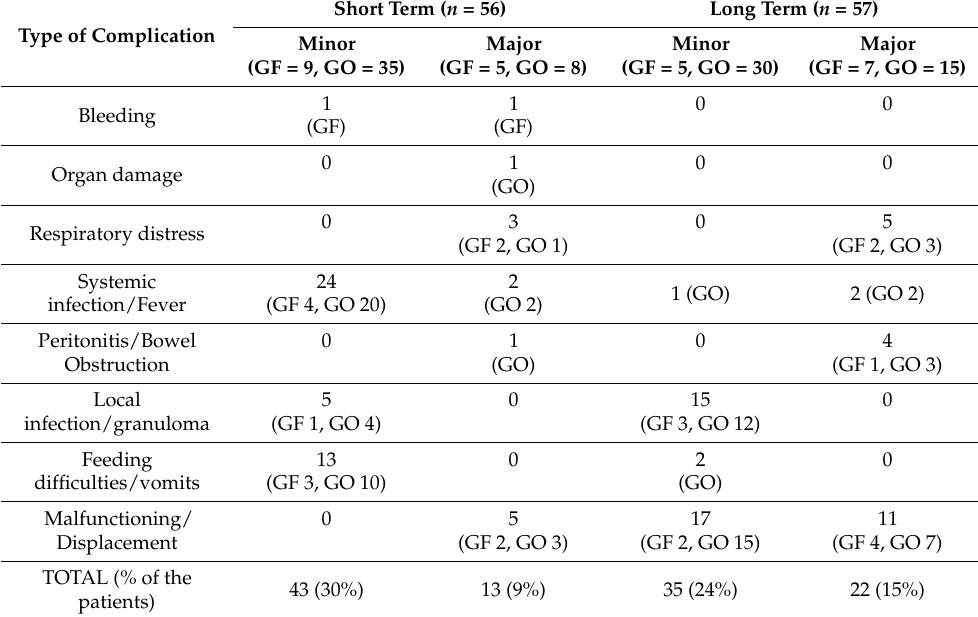
Table 3. List of short and long-term complications. n = number.